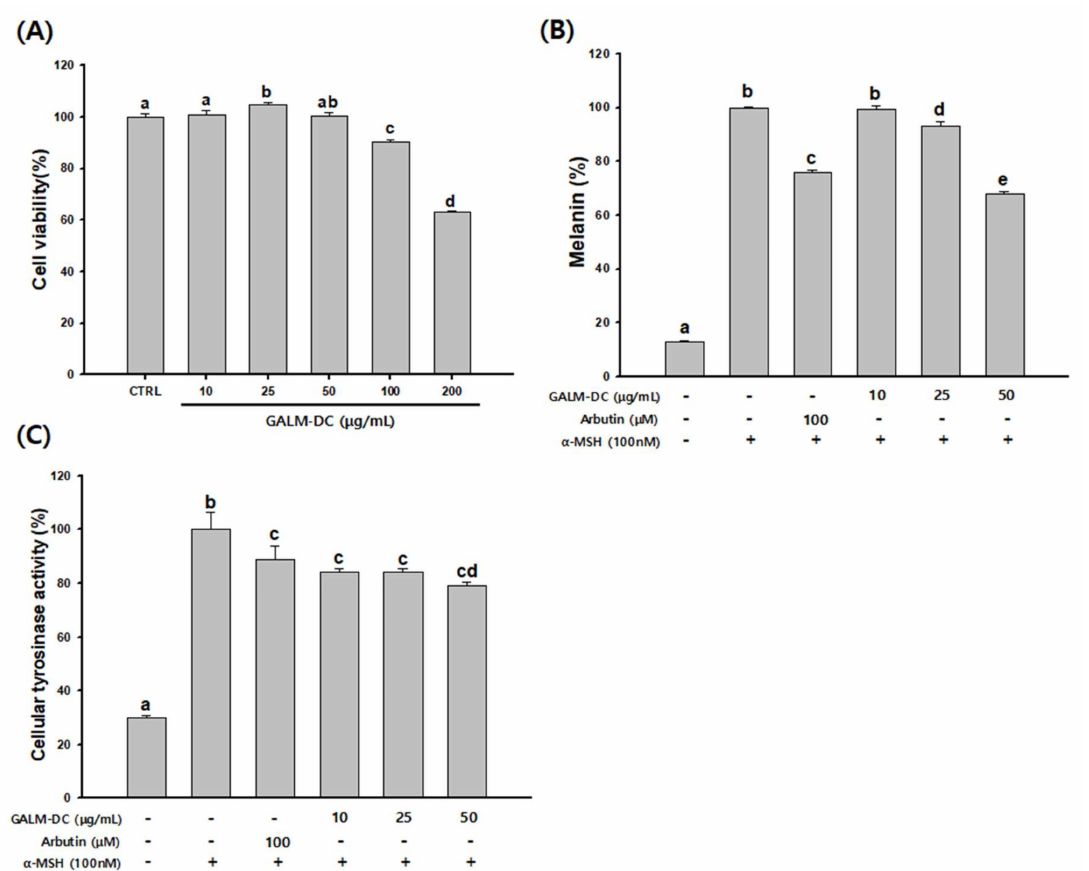
Figure 2. Anti-melanogenesis e ff ects of GALM-DC on B16F10 cells. Cells were cultured with GALM-DC (10–50 µ g / mL) for 48 h. ( A ) Cytotoxicity, ( B ) melanin contents, and ( C ) cellular tyrosinase activity were measured. Arbutin was used as a positive control. Data are presented at the mean ± SD. Values with di ff erent letters (a, b, c, d, e) are significantly di ff erent one from another (one-way ANOVA followed by Tukey multiple range test, p <